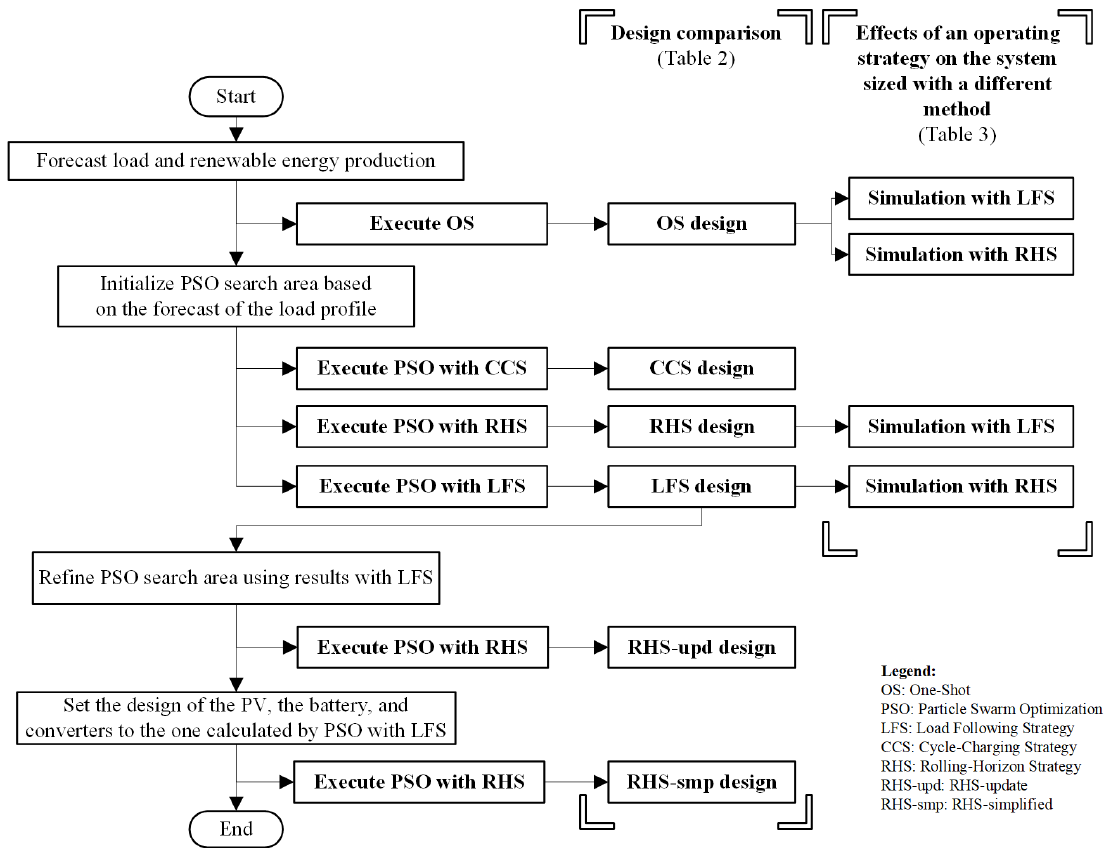
Figure 4. Procedure to compare the heuristic optimization with one-shot, also including the cross-simulations with different operating